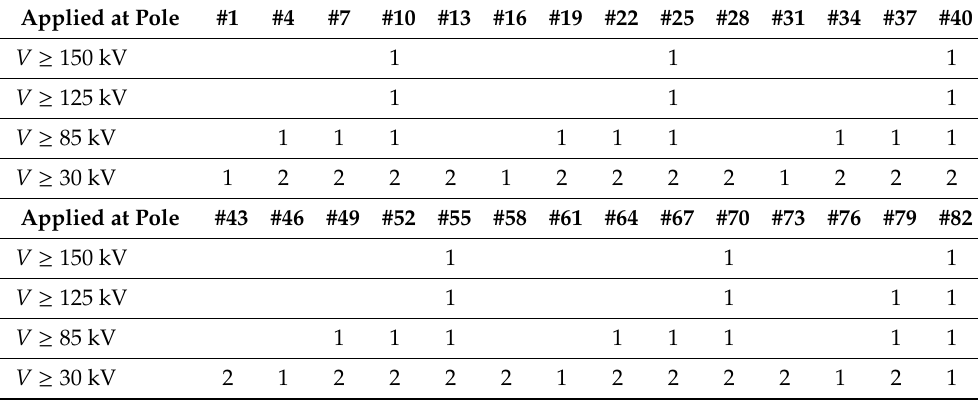
Table 7. Number of transformers with at least one phase reaching the critical overvoltage level. Case 2, dry poles and grounding one intermediate pole between two transformer